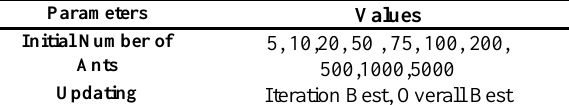
Table 3. Configuration values for Experiment #2.